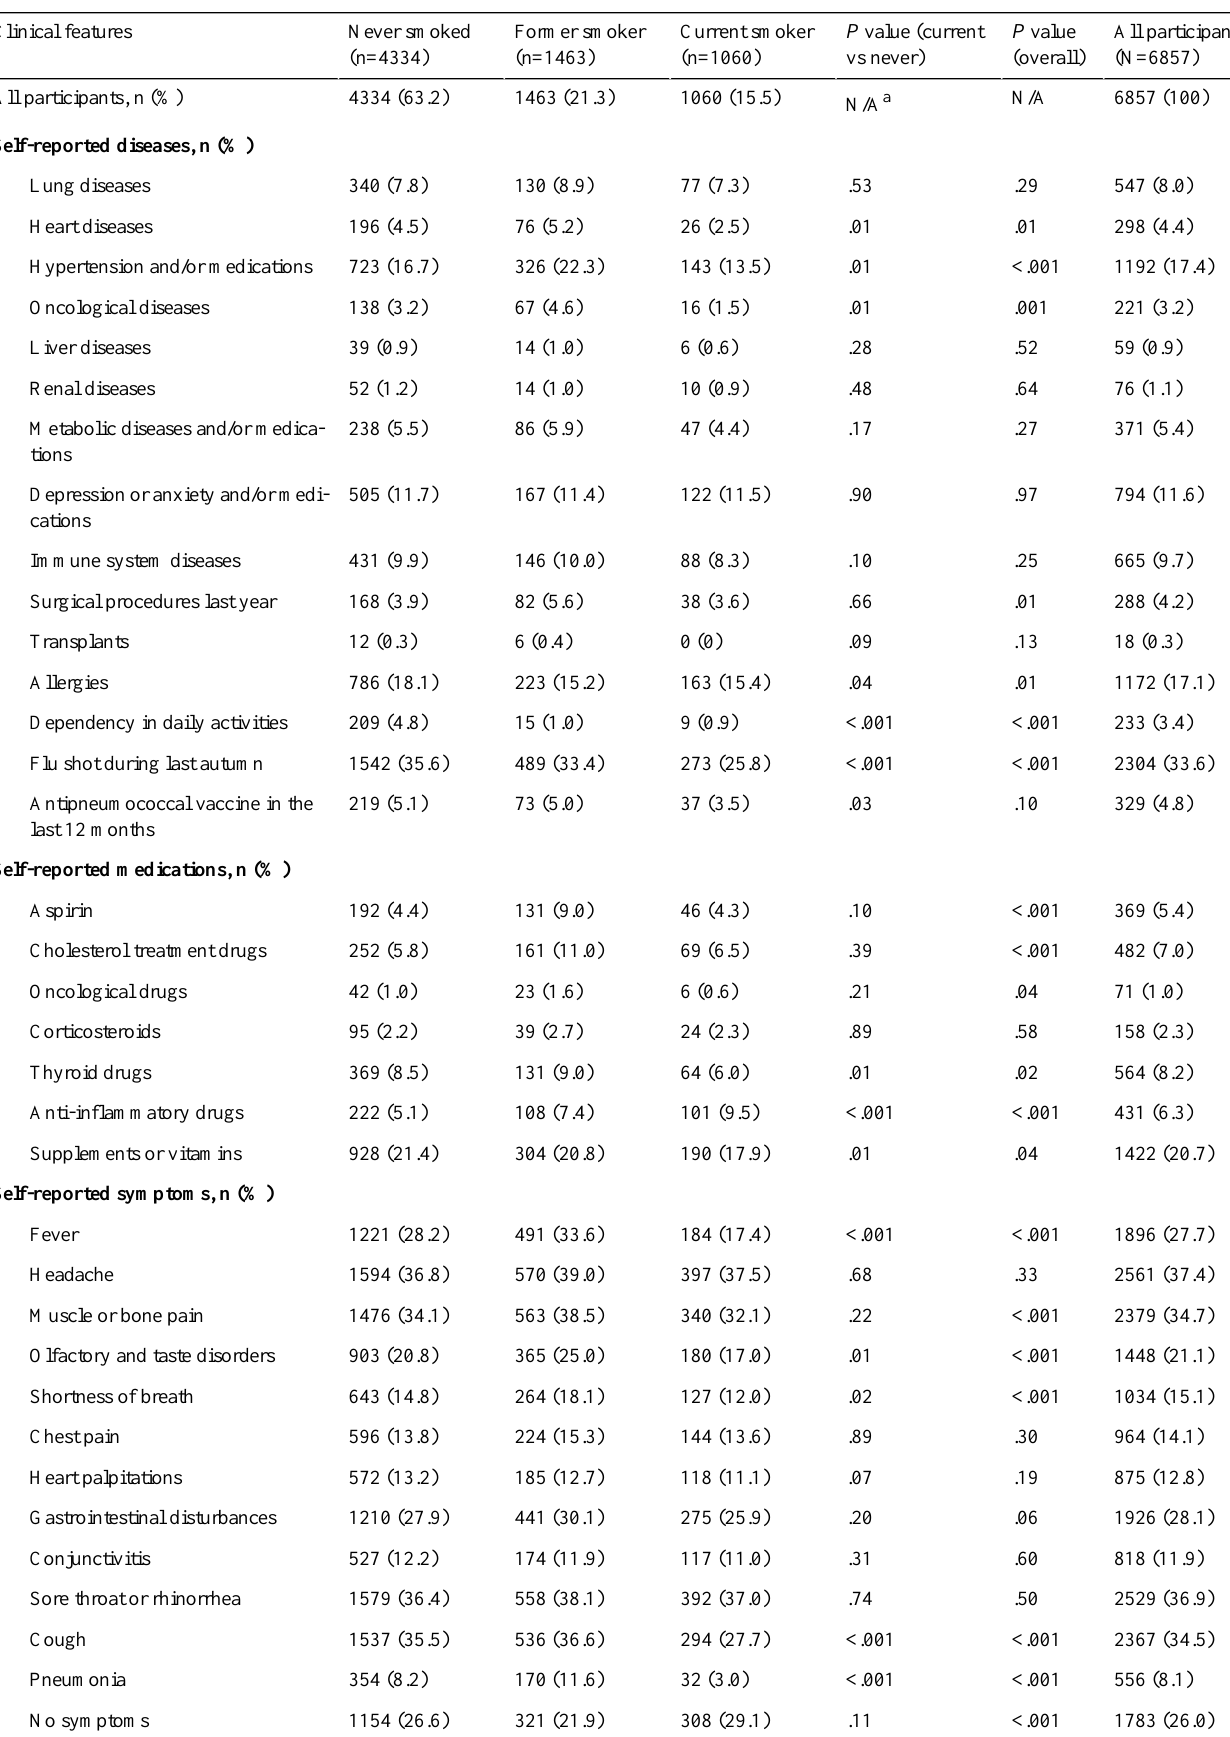
Table 2. Clinical features of study participants with known molecular test results by smoking status in Italy, from April 13 to June 2, 2020